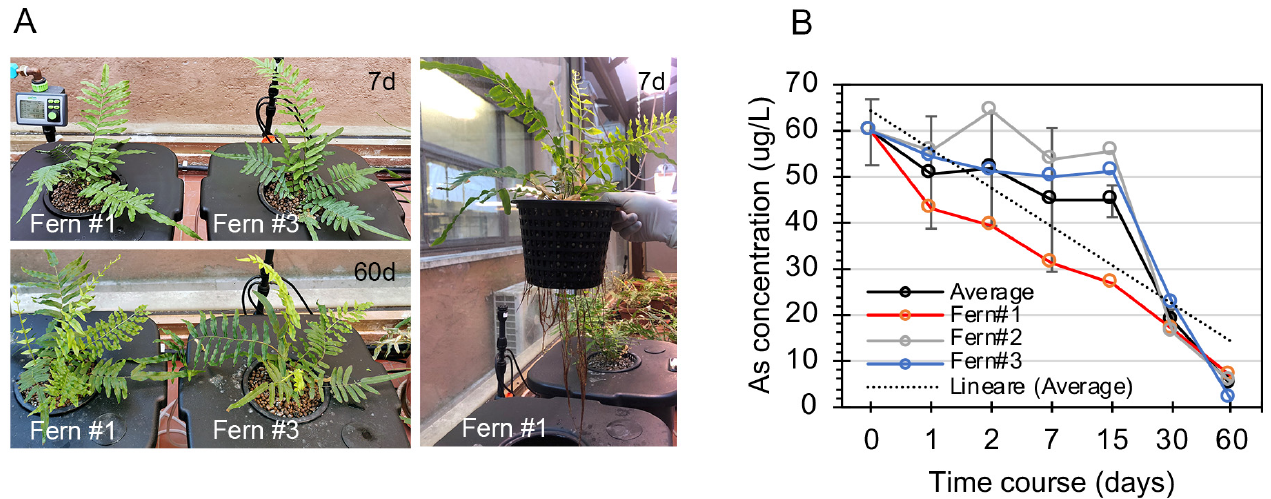
Figure 4. Phytofiltration experiment cycle 1. ( A ) Two Ferns in individual buckets filled with 15 L of naturally As-contaminated groundwater after seven days (upper panel) and 60 days (lower panel). The fronds and roots of Fern 1 after seven days on As treatment (right panel). ( B ) The amount of arsenic in the water at different timepoints is reported for each fern at the indicated times: Fern #1 red line; Fern #2 grey line; Fern #3 blue line. Average value ± SD is indicated by the black line; linear average dashed line.